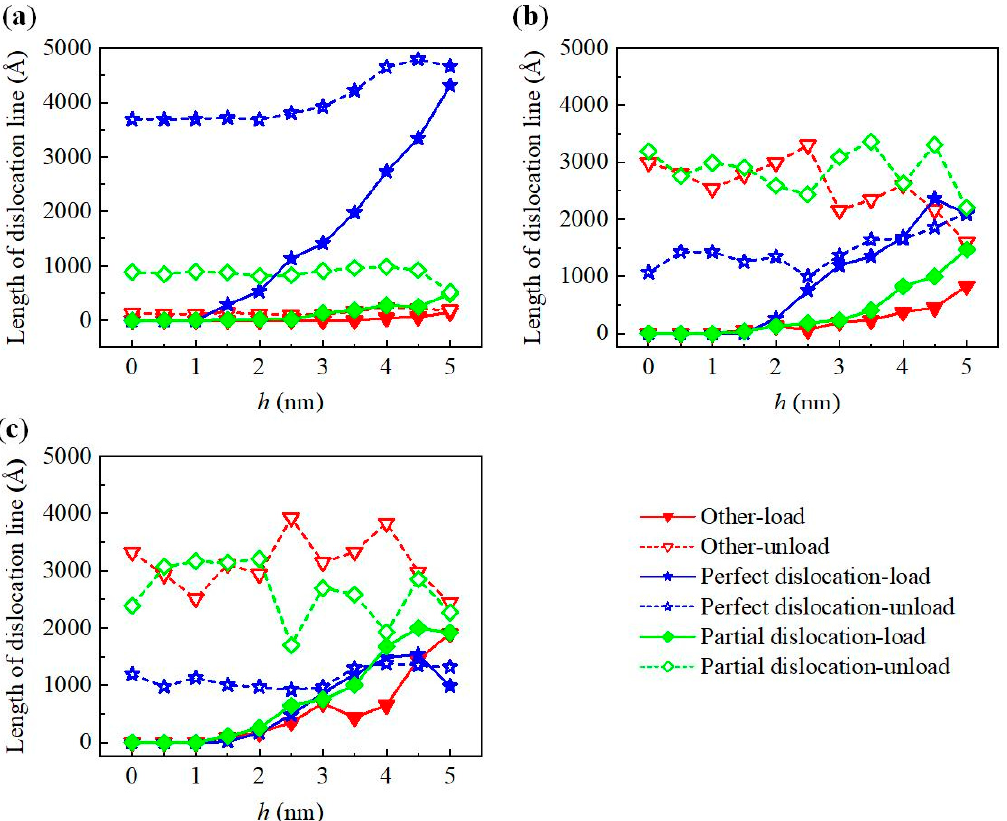
Figure 7. Dislocation line length of three types of SiC single crystal during loading and unloading process: ( a ) 3C-SiC, ( b ) 4H-SiC, and ( c ) 6H-SiC, respectively. process: ( a ) 3C-SiC, ( b ) 4H-SiC, and ( c ) 6H-SiC,